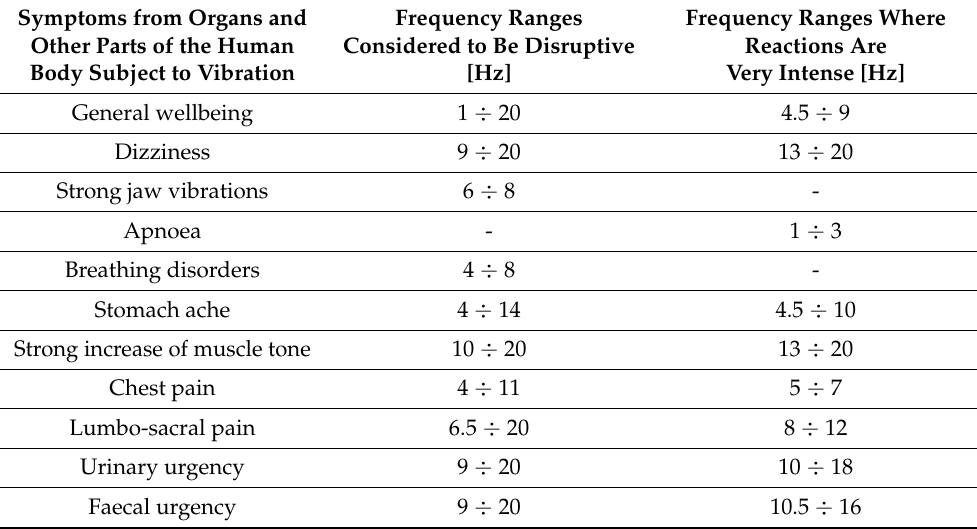
Table 3. Examples of ranges of the resonance frequencies for subjective human reactions [33]. Symptoms from Organs and Other Frequency Ranges Parts of the Human Body Subject Considered to Be Dis- to Vibration